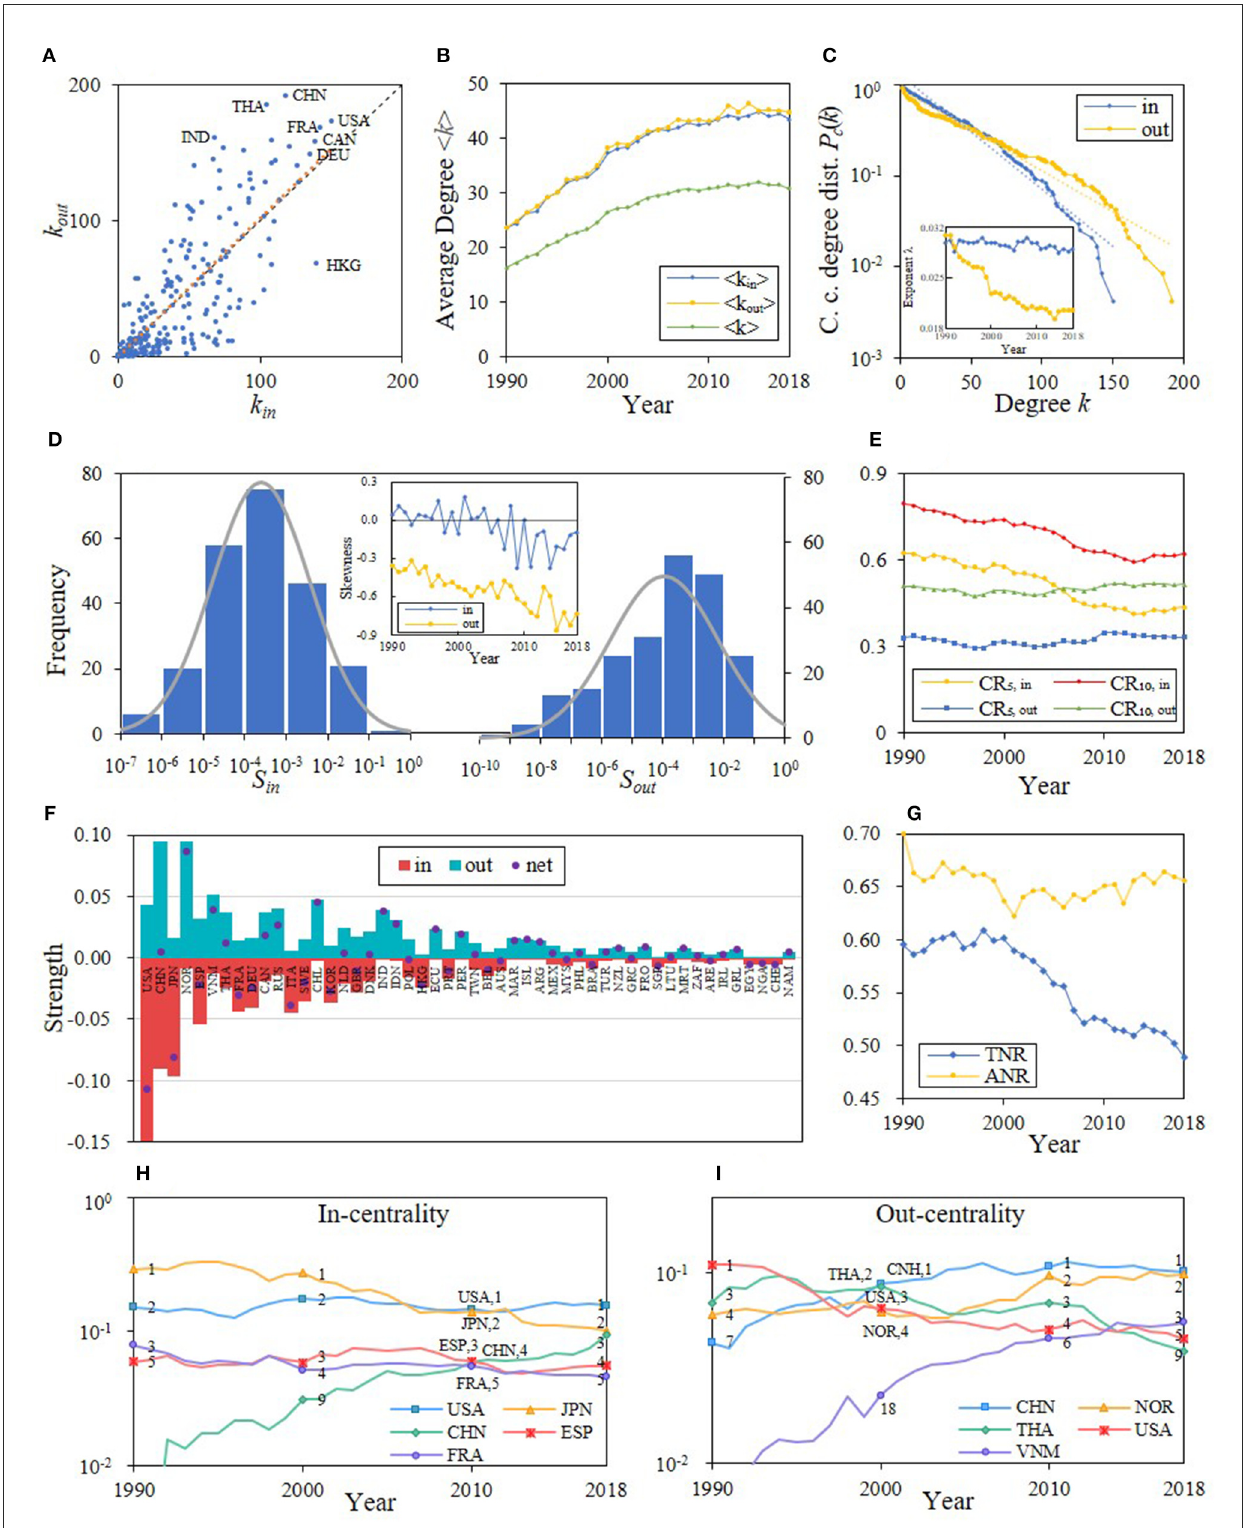
FIGURE3 Network node properties. (A) Scattered plot of out-degree versus in-degree for the year 2018, with the orange dashed line as the asymptote and the black dashed line as the diagonal. (B) Dynamics of average in-, out-, and undirected degrees. (C) Complementary cumulative in- and out-degree distributions for 2018, with dashed lines as the asymptotes; and λ of exponential distributions of time (inset). (D) In- and out-strength distributions for 2018; and skewness of lognormal distributions of time (inset). (E) The sums of in- (out-) strengths of 5 and 10 largest importers (exporters), e.g., the shares of the 5 and 10 largest importers (exporters) in total fish trade value. (F) The in-, out-, and net-strength of the top 50 traders in tot-strength in 2018. (G) Dynamics of average net-strength ratio (ANR) and total net-strength ratio (TNR). (H, I) In- (out-) centrality dynamics of the top five central importers (exporters) in the 2010’s over the period